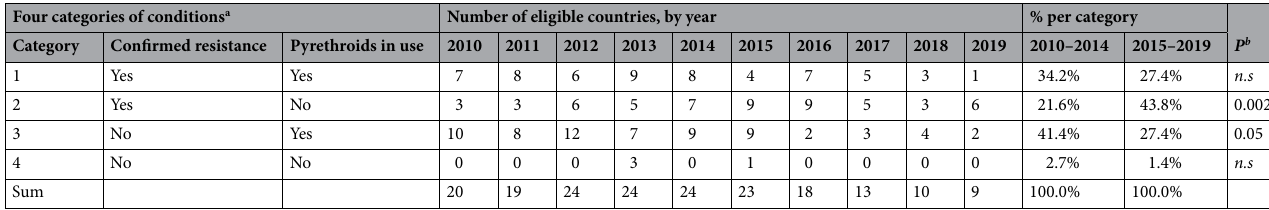
for 79.9% bendiocarb and 20.1% propoxur, pooled over years). From 2014, the contribution of carbamates and pyrethroids declined but that of organophosphates (i.e., for 93.5% pirimiphos-methyl and 6.5% temephos, pooled over years) increased. Four African countries that had shifted to a new formulation of pirimiphos-methyl relied exclusively on this insecticide for IRS for four to six consecutive years. From 2018, the contribution of organo- phosphates declined while that of neonicotinoids (clothianidin as only active ingredient used) increased. In 2019, neonicotinoids were the most common insecticide class used for malaria control in the African Region (38.5%